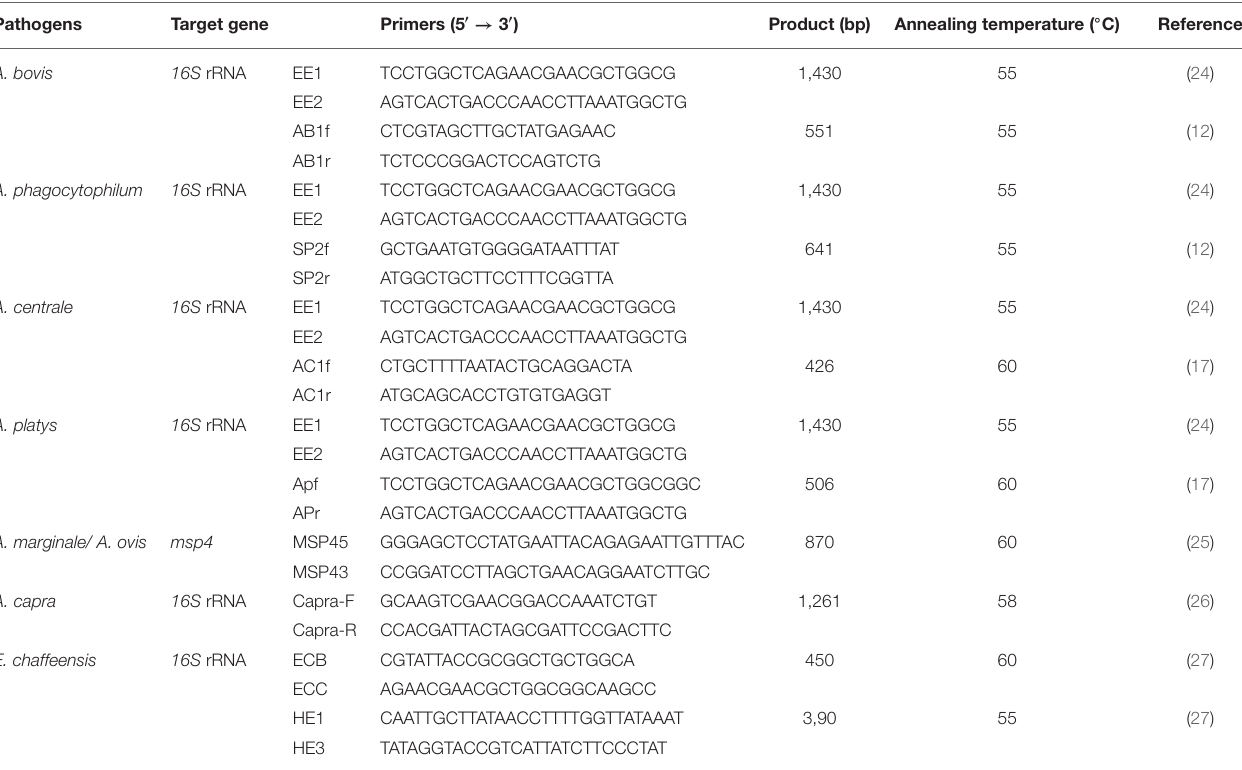
TABLE 1 | Primers used in this study to detect Anaplasma spp. and E. chaffeensis in Tibetan sheep and yaks in Qinghai, China. Pathogens